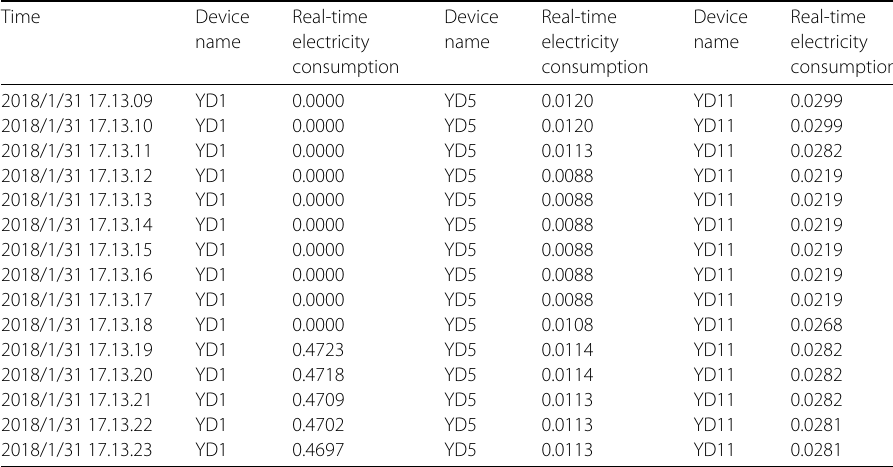
Table 7 Real-time power consumption of equipment group 5